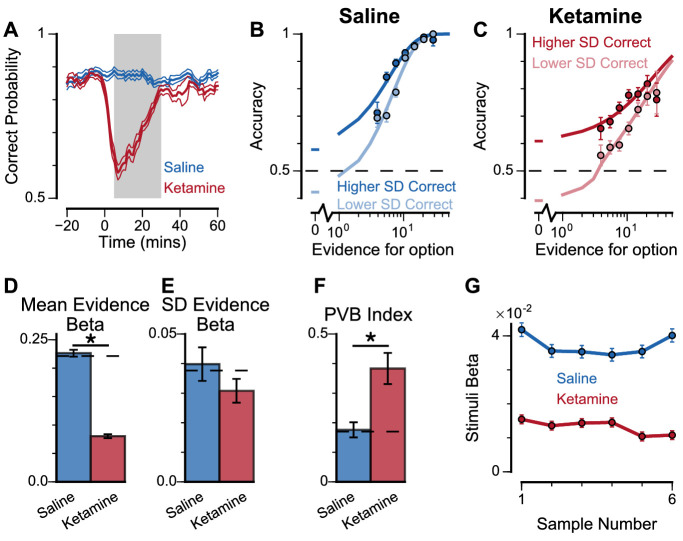
Experimental effects of ketamine on evidence accumulation behaviour produce an increased pro-variance bias, consistent with lowered excitation-inhibition balance.(A) Mean percentage of correct choices across sessions made by monkeys relative to the injection of ketamine (red) or saline (blue). Shaded region denotes ‘on-drug’ trials (trials 5–30 min after injection) which are used for analysis in the rest of the figure. (B, C) The psychometric function when either the ‘Lower SD’ or ‘Higher SD’ streams are correct, with saline (B) or ketamine (C) injection. (D–F) Ketamine injection impairs the decision-making of the monkeys, in a manner consistent with the prediction of the lowered E/I circuit model. Dashed lines indicate pre-injection values in each plot. (D) The regression coefficient for mean evidence, under injection of saline or ketamine. Ketamine significantly reduces the coefficient (permutation test, p<1×10−6), reflecting a drop in choice accuracy. (E) The evidence standard deviation regression coefficient, under injection of saline or ketamine. Ketamine does not significantly reduce the coefficient (permutation test, p=0.152). (F) Ketamine increases the PVB index (permutation test, p=8×10−6), consistent with the model prediction of the lowered E/I circuit. (G) The regression weights of stimuli at different time-steps, for the monkeys with saline or ketamine injection. Ketamine injection lowers and flattens the curve of temporal weights, consistent with the lowered E/I circuit model. Errorbars in (A) indicate the standard error mean, in all other panels errorbars indicate the standard error.